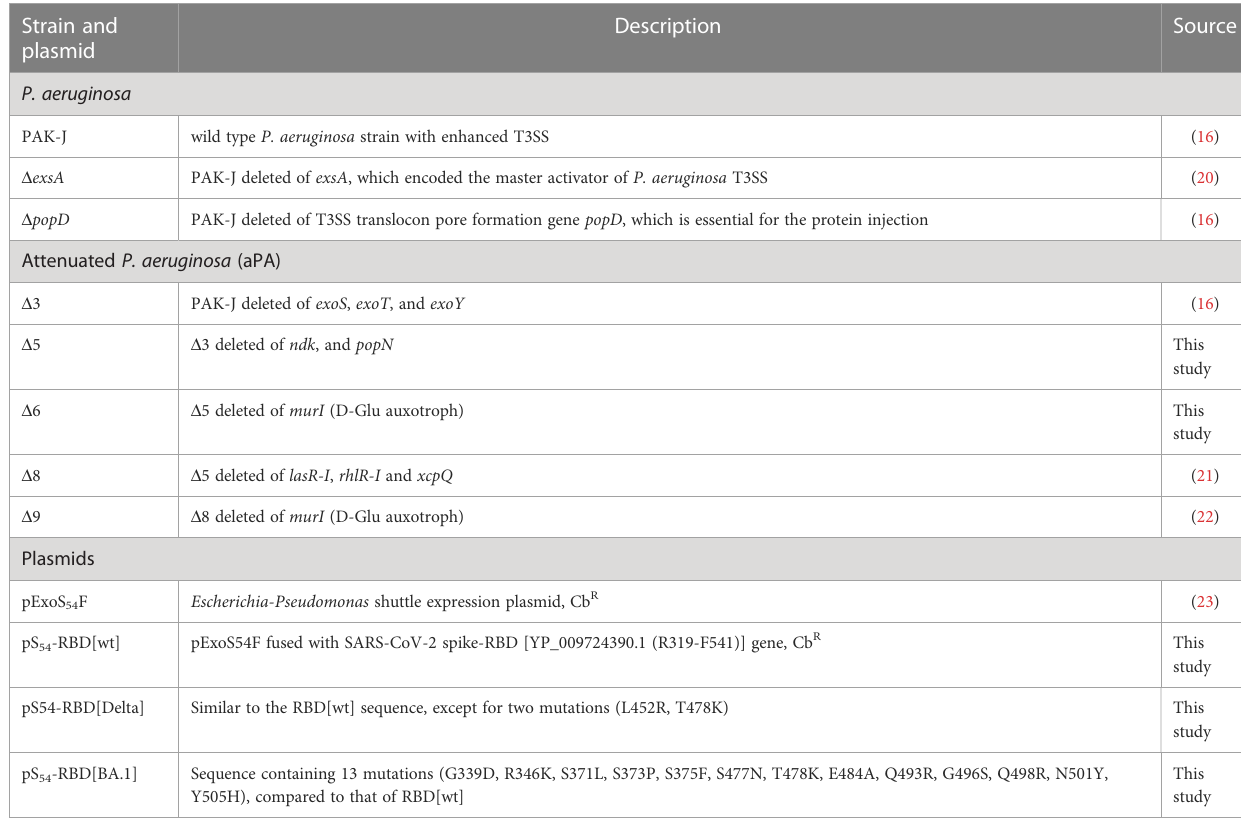
Description Source